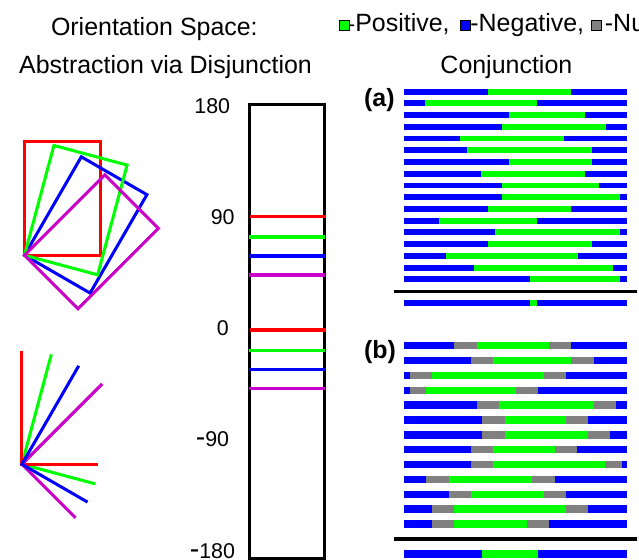
Figure 6. Illustration of the functions of disjunction and conjunction. Left: When a rectangular object (e.g., a paper) rotates about one of its vertices, its four edges sweep through different orientations. The conjunction of two neighboring edges is shown in one color in the lower left corner; its mapping on the orientation space (displayed vertically) is shown as a pair of horizontal lines. A disjunction of all such conjunctions that cover the entire space specifies the orientation-independent right angle, an abstract quantity, that is physically a non-realizable object. Right: The results of the conjunction on the correlation profiles in the orientation space are shown with two examples. Each horizontal color bar represents a correlation profile of an active agent (say, a neuron) in the orientation space. The correlation index is shown on the top (green: Positive, blue: Negative, gray: Null). All color bars cover the same range of orientation space with a resolution of 1 degree of arc. The rest of the space extending to the left and to the right of the bars bears a negative correlation. The result of conjunction on the columns of values is displayed below the black line in respective diagrams. The data is taken from a simulation, as presented in Section 7. In fact, the results stay consistent, even when each column within the band of values is taken from arbitrary different semantic spaces or when the bar represents a continuous range in a